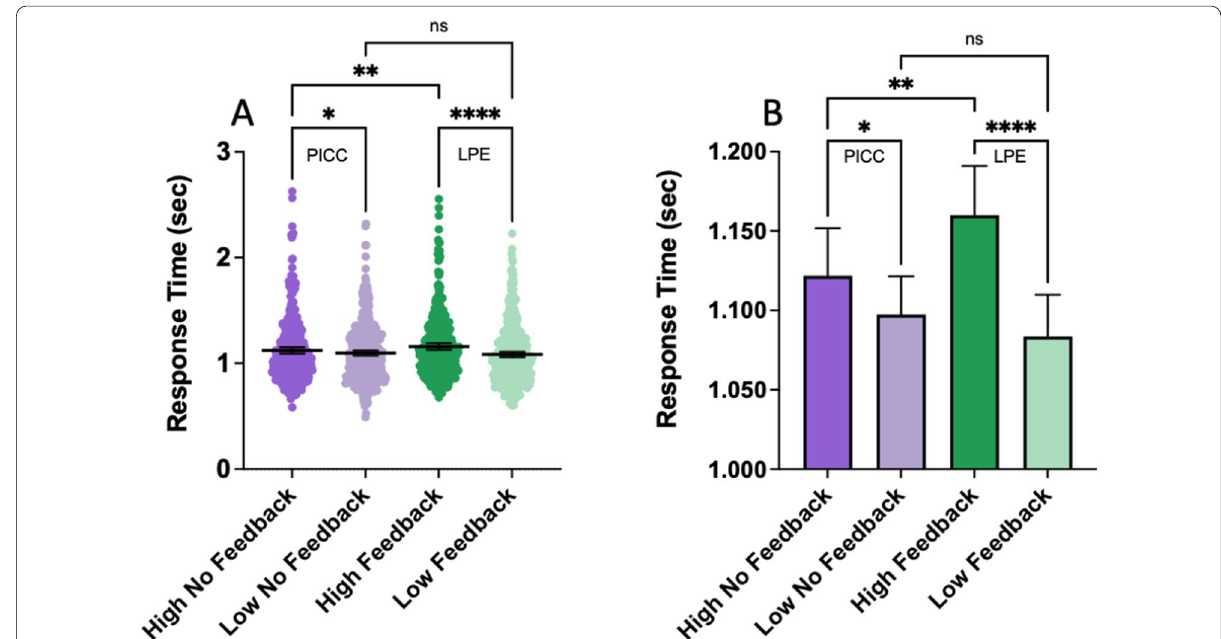
Fig. 3 Median response time as a function of block type. RTs < 11 s were analyzed. A RT distributions with the graph truncated at 3 s for display purposes. Black lines show the mean. B Means of the median RTs on a much finer scale. Error bars show